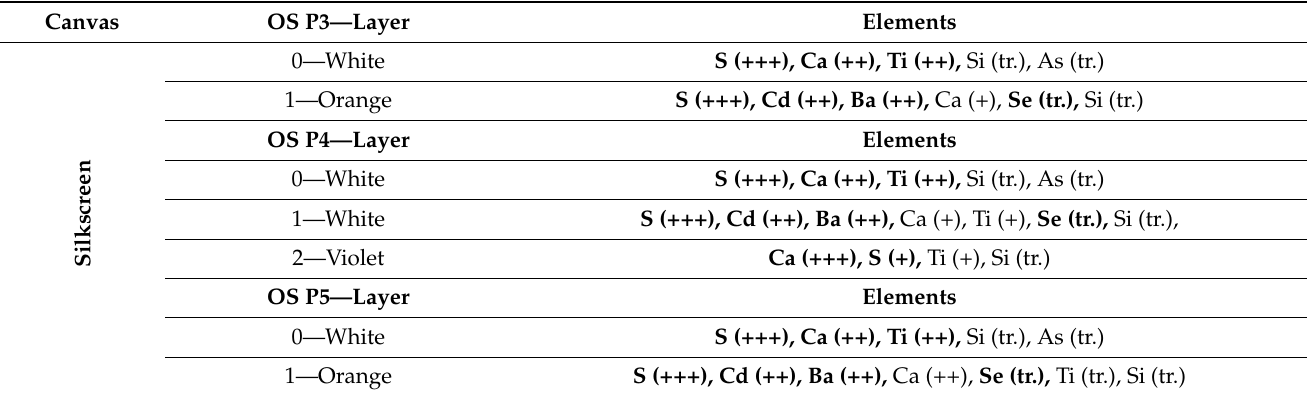
Table 5. Elements detected by EDX per layer on the cross-sectioned OS P3, OS P4, and OS P5 samples. The main elements are written in bold. (+++ high, ++ moderate, + low concentration, tr.